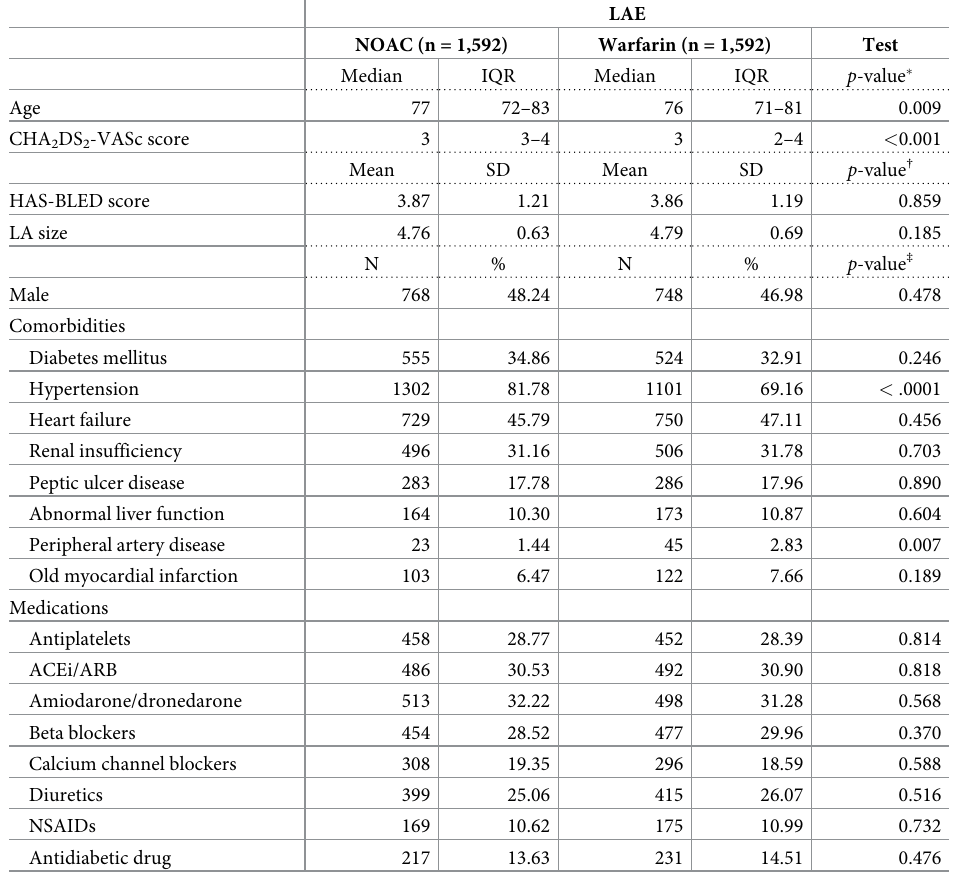
Table 1. Baseline characteristics of study